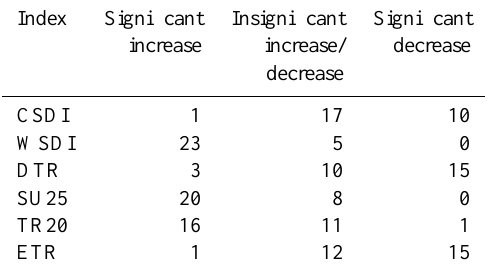
Table 2. Number of stations with significant increasing (0.1 of sig- nificance level) for annual extreme precipitation indices during the period of 1958–2013.